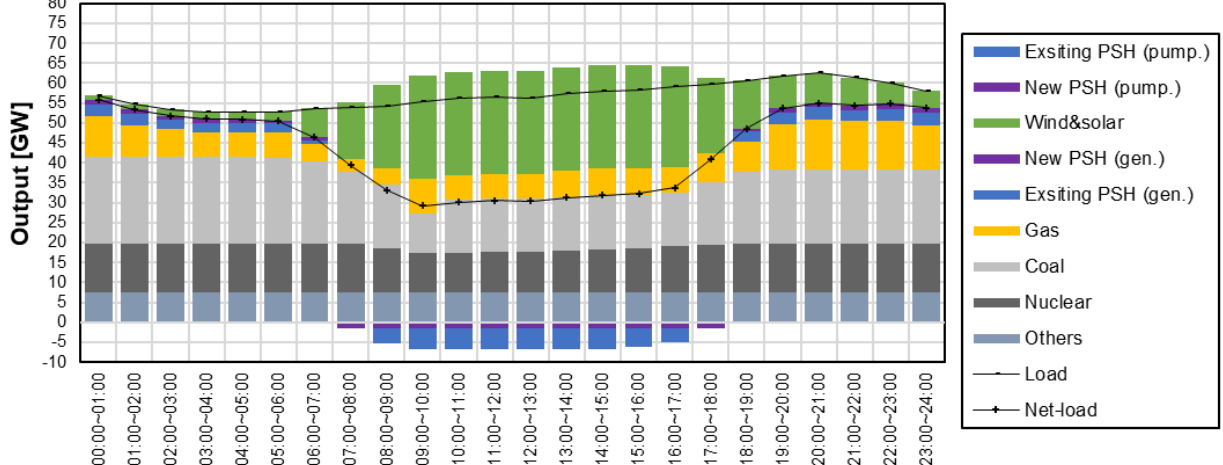
Figure 14. The UC solution diagram of Scenario D.